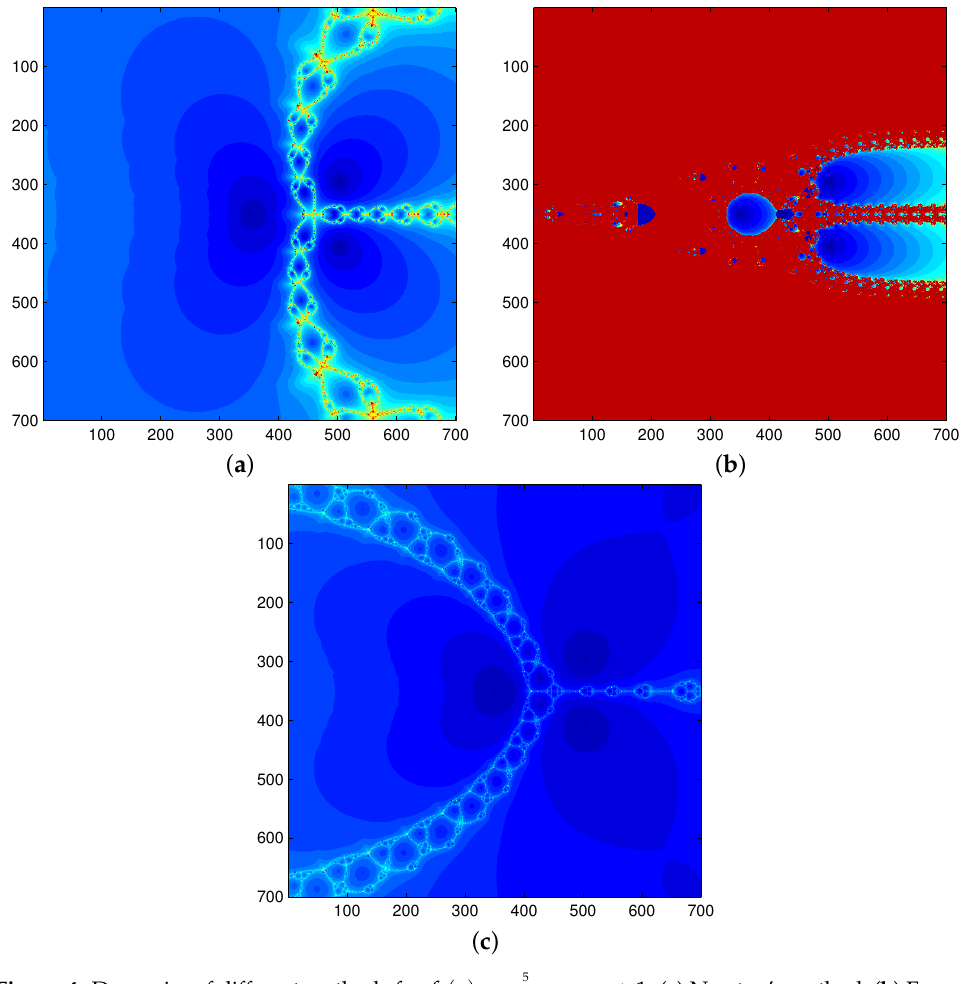
Figure 4. Dynamics of different methods for f 1 ( x ) = x 5 2 − exp x + 1: ( a ) Newton’s method; ( b ) Fang et al.’s method; ( c ) proposed